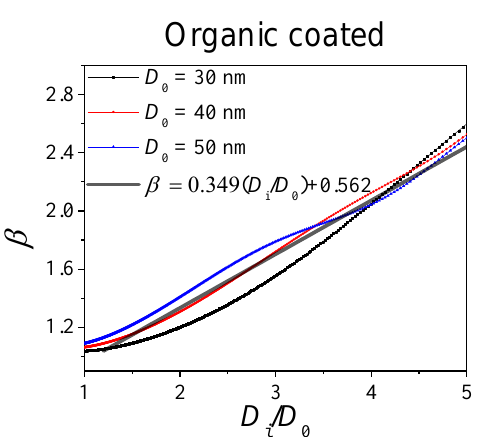
Figure 10. Relationship of absorption exponent β with coating thickness ( D i / D 0 ) for organic-coated soot particles (core size D 0 at 30, 40, 50 nm).